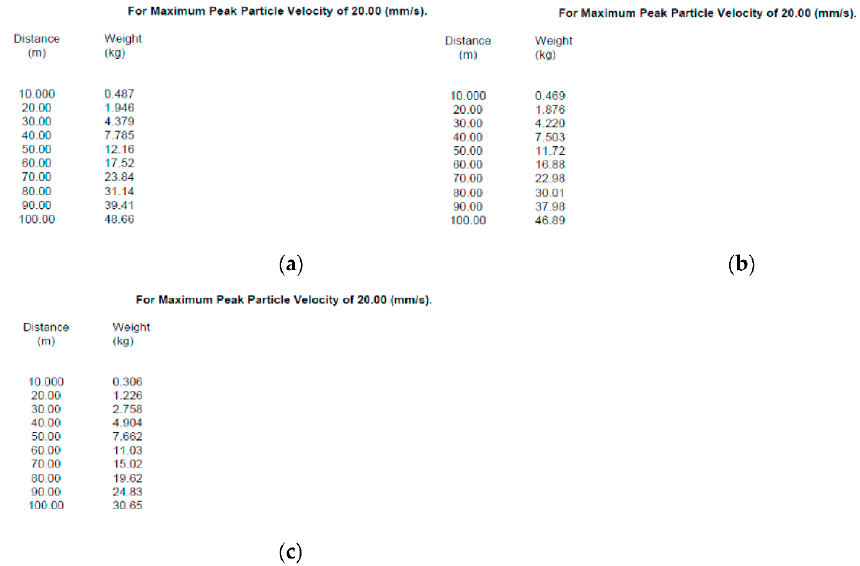
Figure 5. “Blastware” printout of the permitted charge weight per delay for the required distances from the blasting zone with the selected maximum PPV of 20 mm/s according to the category of the surrounding structures: ( a ) for a confidence interval of 68.27%; ( b ) for a confidence interval 95.45%; and ( c ) for full dataset (100.00%). and ( c ) for full dataset